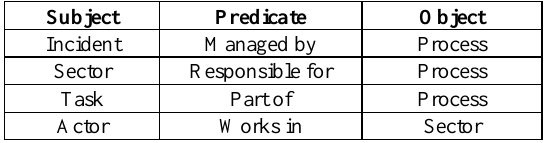
Table 1. RDF triplets of conceptual diagram shown in Figure